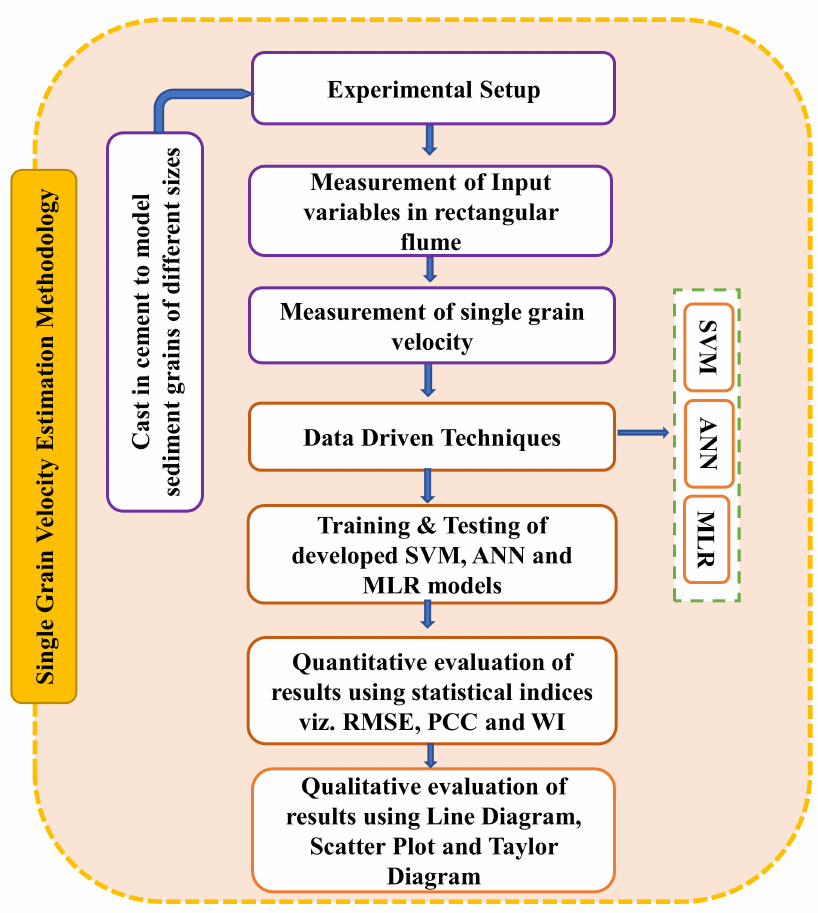
Figure 2. Flow diagram for single grain velocity